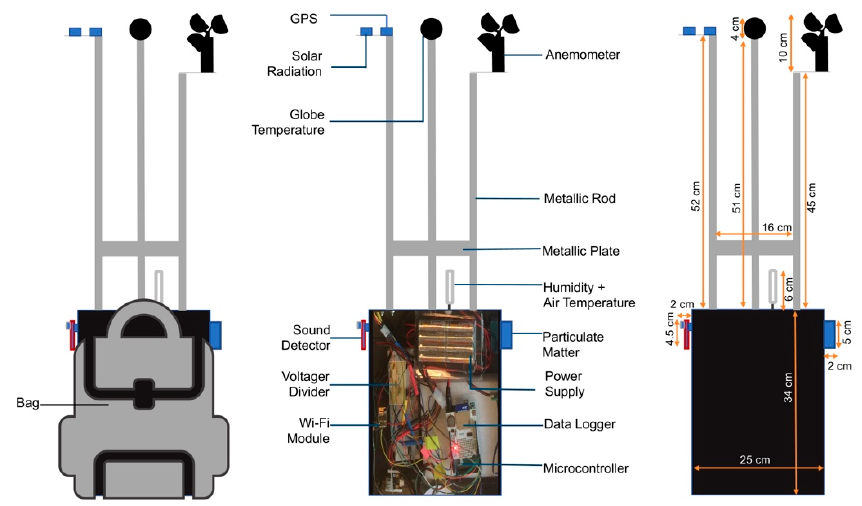
Figure 4. The model’s exterior frame and setting of the components.